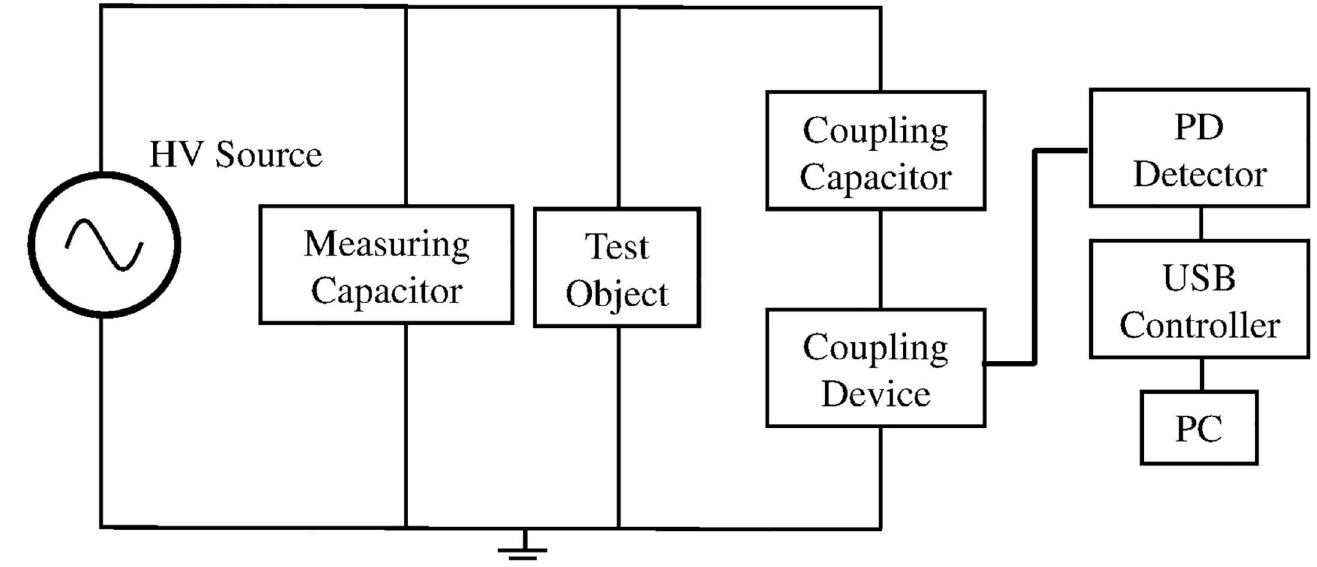
Fig 1. Block diagram of PD measurement